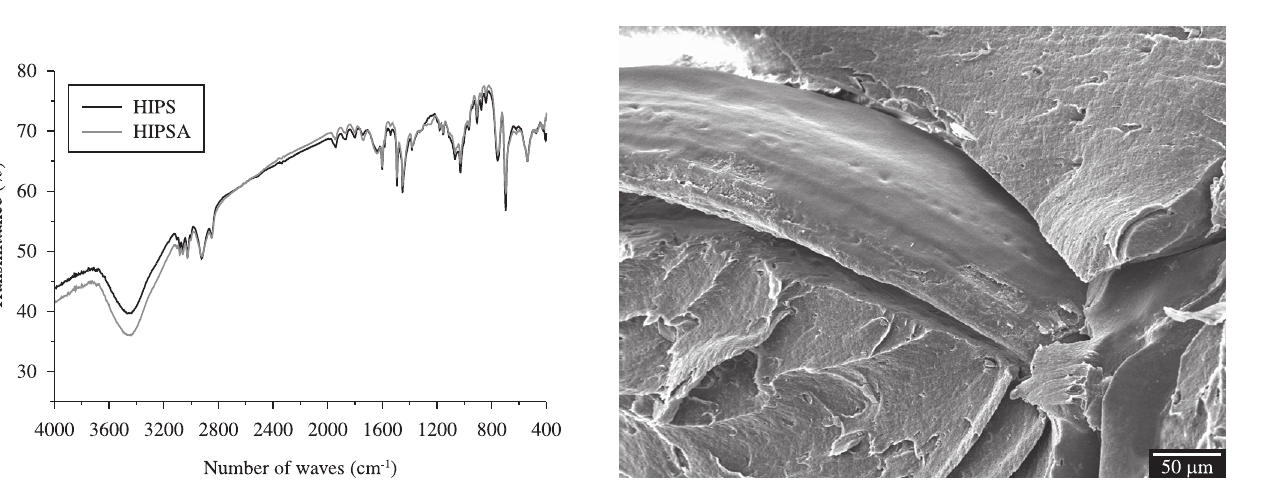
Figure 2. FTIR spectrum of polystyrene (HIPS) and polystyrene/açaí fiber composite (HIPSA).